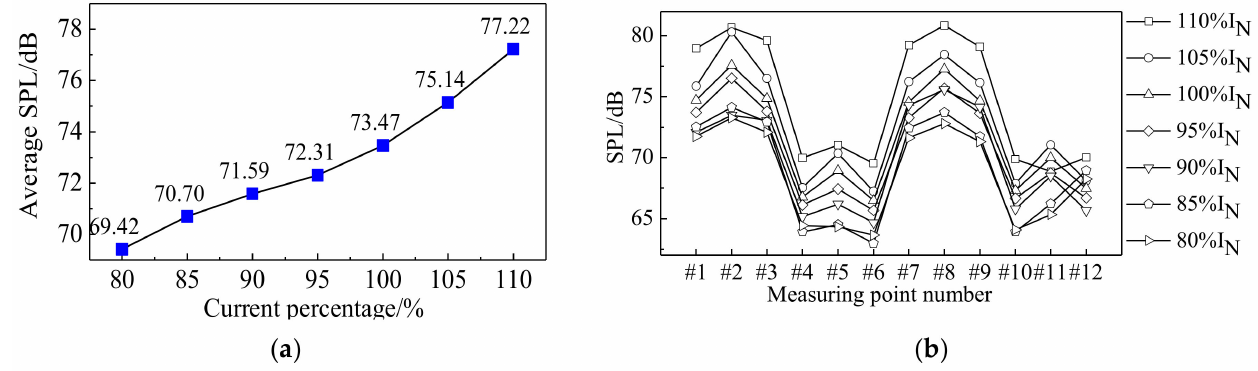
Figure 13. Average sound pressure levels around the transformer. ( a ) ASPLs at different I N levels; ( b ) SPLs of each point.